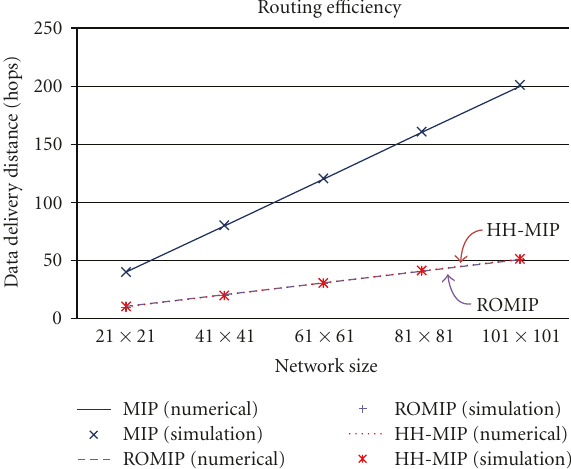
Figure 9: Comparison of routing e ffi ciency between di ff erent